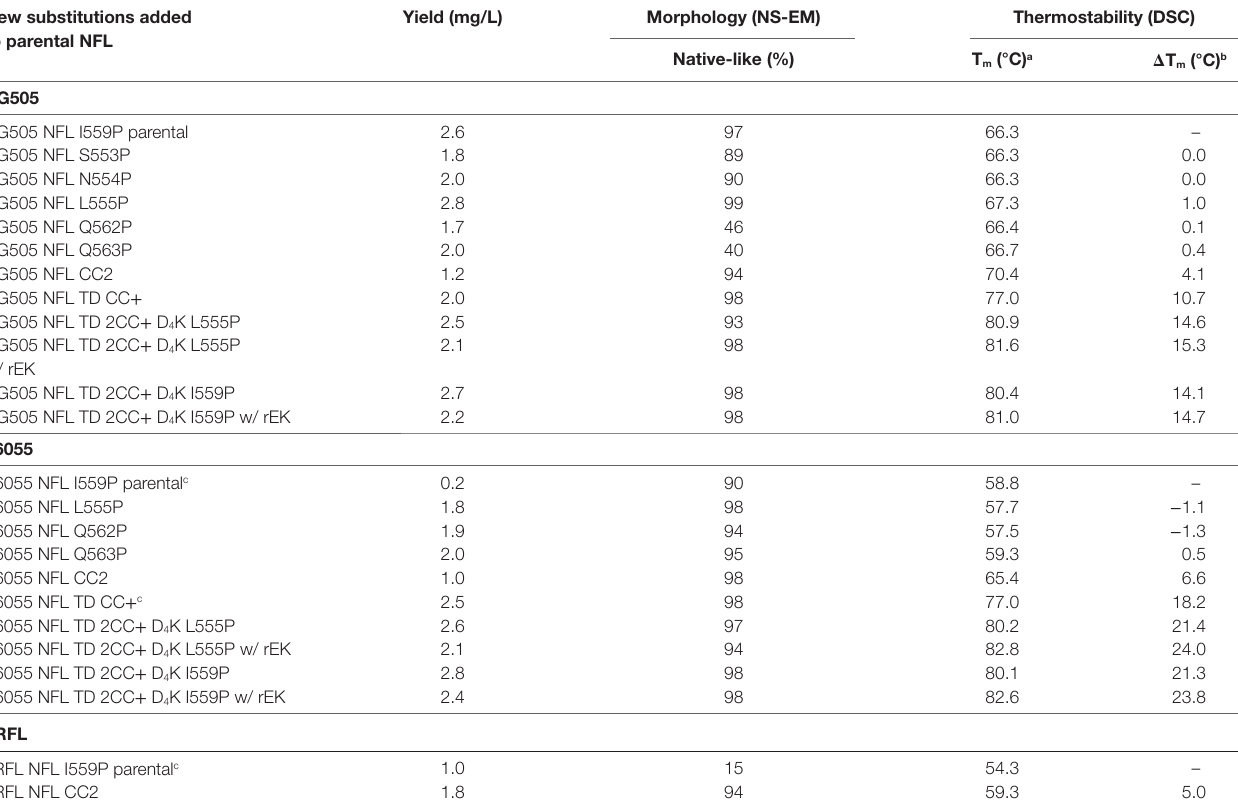
the clade C 16055 NFL, which is inefficient in its original I559P design in terms of yielding a high percentage of native­like trimers (19). All five proline substitutions (S553P, N554P, L555P, Q562P, and Q563P) were compatible within the 16055 NFL backbone (Figure S3A in Supplementary Material), displaying a homog­ enous trimer peak by SEC. In contrast, the 16055 NFL I559P SEC peak contained only small fractions of trimers ( Figure 2A ; Figure S3B in Supplementary Material), as previously reported (19). The trimer peak on SEC was slightly shifted “to the right” for 16055 NFL L555P design, consistent with improved trimer formation and yield ( Table 1 ). However, some trimer heteroge­ neity remained, so we used GE136­affinity negative selection to remove non­native trimers and other Env conformers. Following negative selection, the yield of the 16055 NFL L555P trimers were increased compared to the original I559P trimers ( Table 1 ). DSC analysis revealed that the L555P substitution generated more homogenous 16055 NFL trimers, with comparable ther­ mostability, compared to the I559P change ( Figure 2B ; Figure S3C in Supplementary Material). NS­EM 2D average TaBle 1 | Biophysical characterization of stabilized trimers from 16055, BG505, and JRFL isolates. new substitutions added Yield (mg/l) Morphology (ns-eM) Thermostability (Dsc) to parental nFl